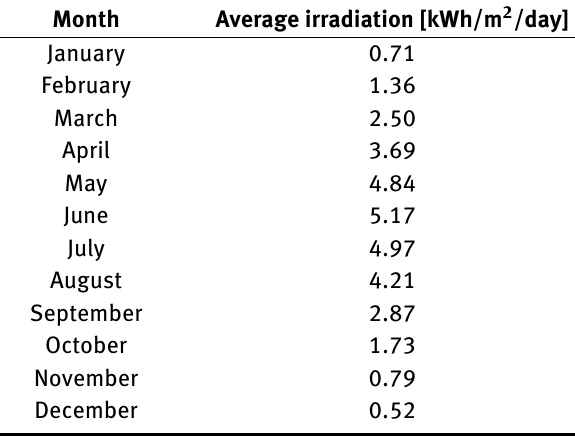
Table 3: Average daily irradiation [9]. Table 4: Daily energy consumed by collectors in given months (Variant